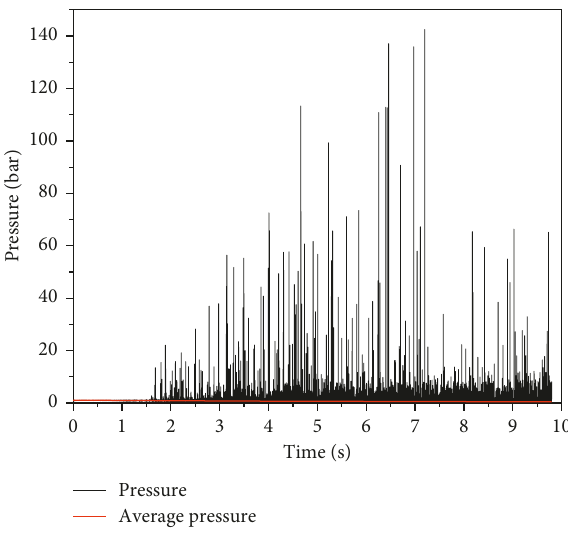
Figure 15: Relationship between pressure and